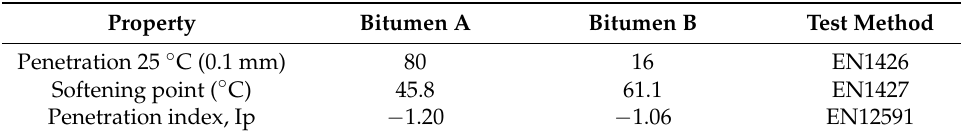
Table 1. Empirical properties of the bitumen